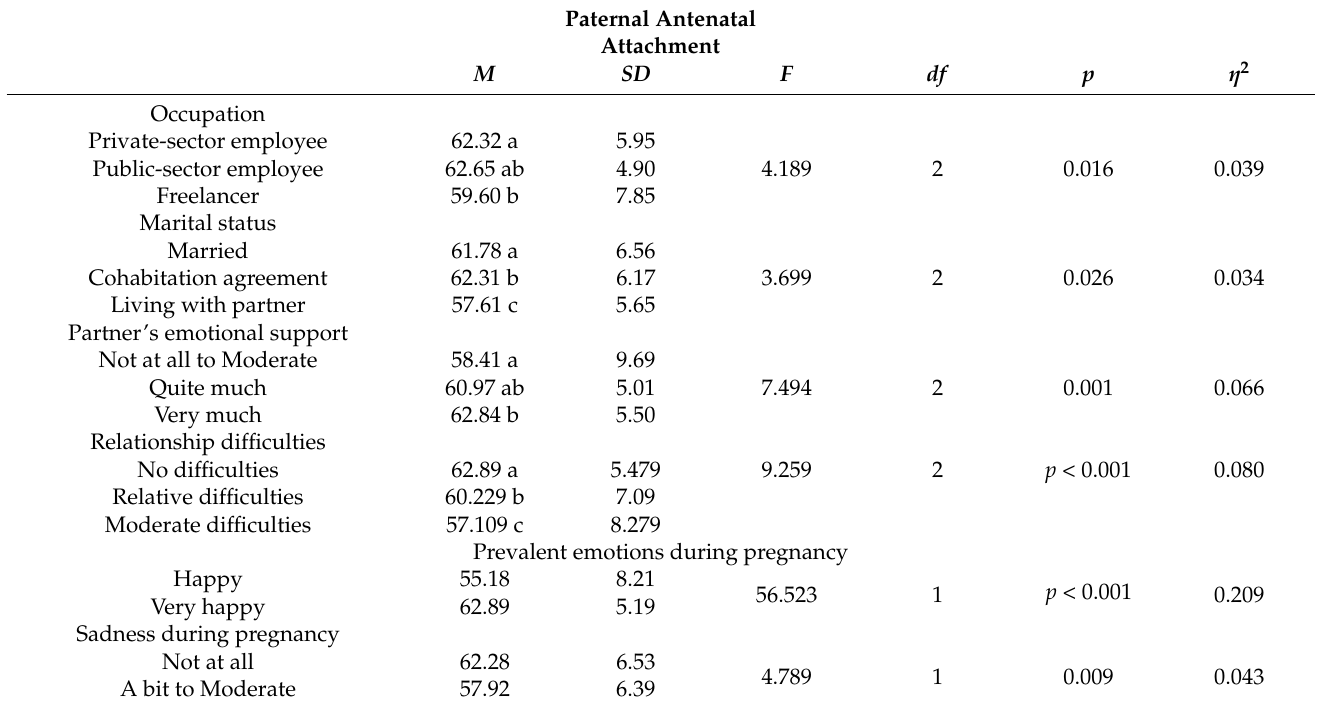
Table 2. Univariate Analyses of Variance of Paternal Antenatal Attachment. Paternal Antenatal